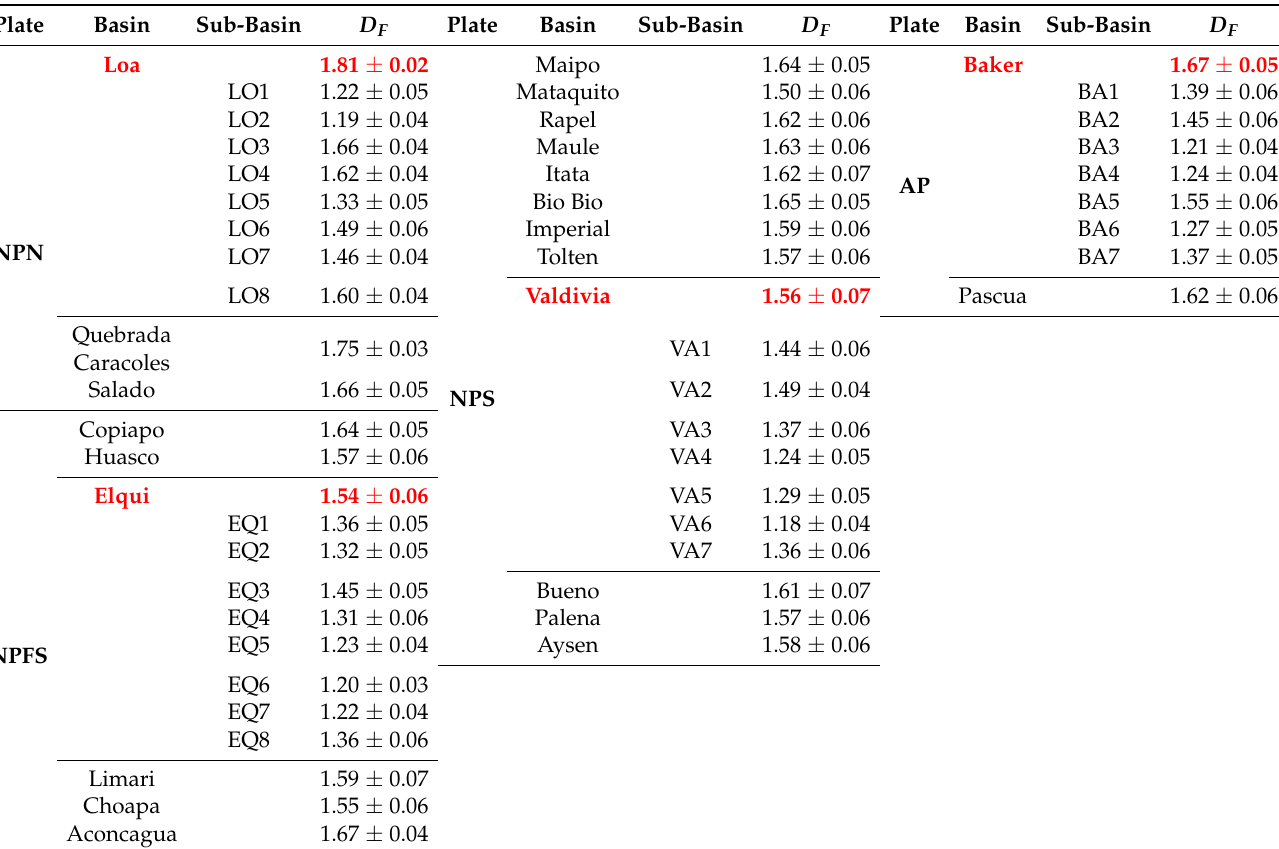
Table 3. Fractal dimension estimated from Fractalyse ( D F ) for Loa, Elqui, Valdivia and Baker networks (marked in red). The networks were sorted by tectonic-segment influence. Sub-networks were also included. The mean error of each data, ∆ F , was also included for reference. Plate Basin Sub-Basin D F Plate